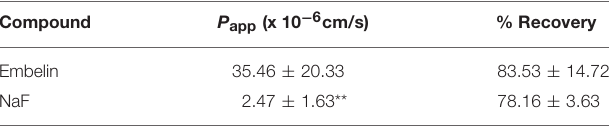
TABLE 1 | P app values and % recovery of embelin and NaF. Compound P app (x 10 − 6 cm/s) % Recovery Embelin 35.46 ±